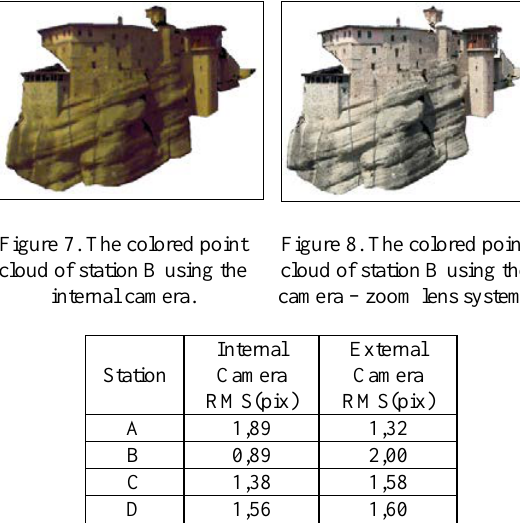
Figure 11. Orthomosaic of station B and D.